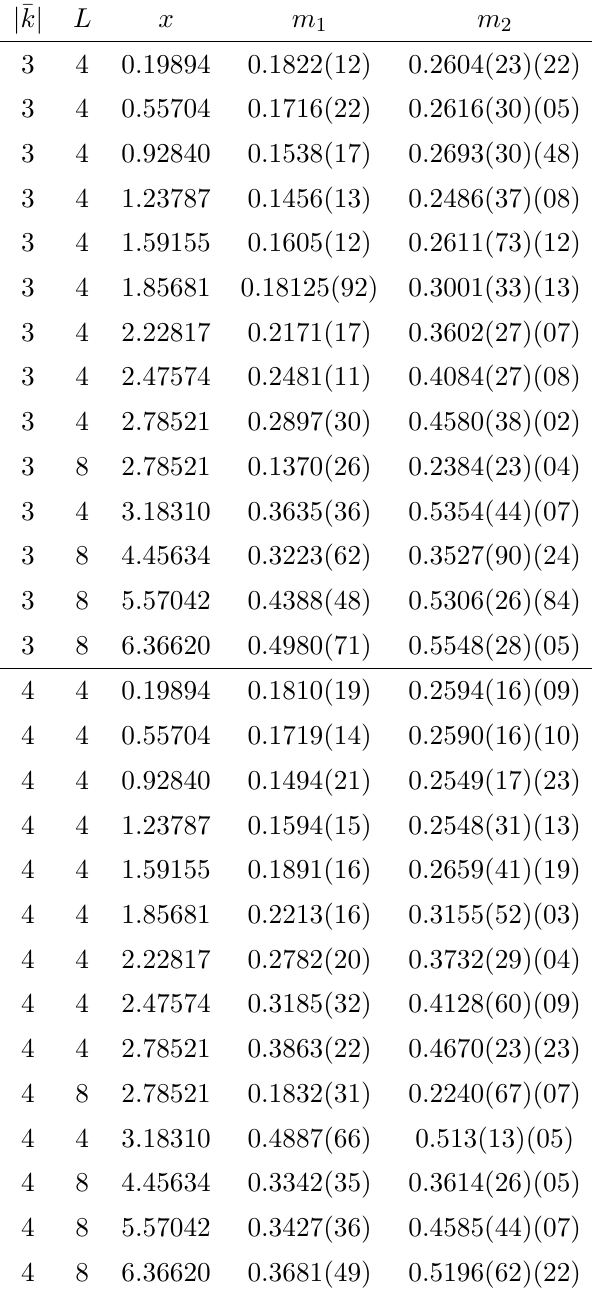
Table 26. Mass gap and next excited state energy (in lattice units) in the zero-electric (cid:13)ux scalar sector for SU(17) (continued).